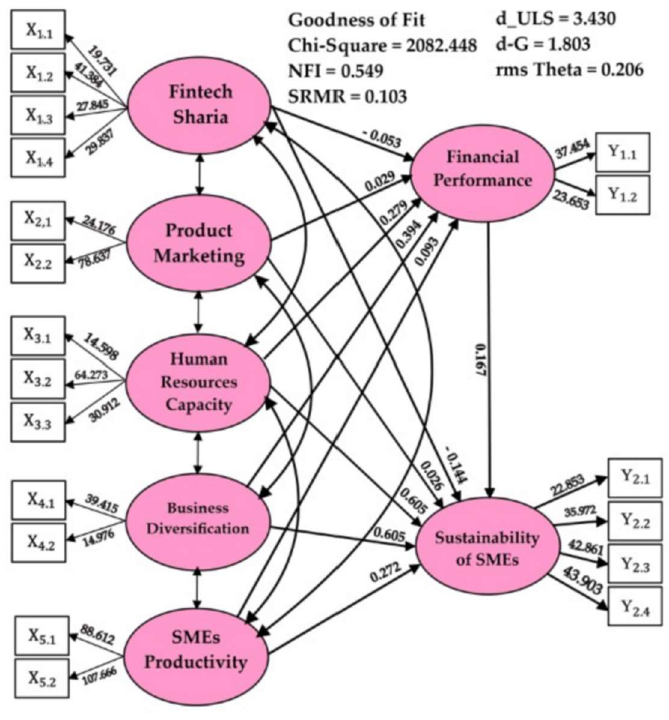
Figure 4. Struktur equation modeling (SEM).